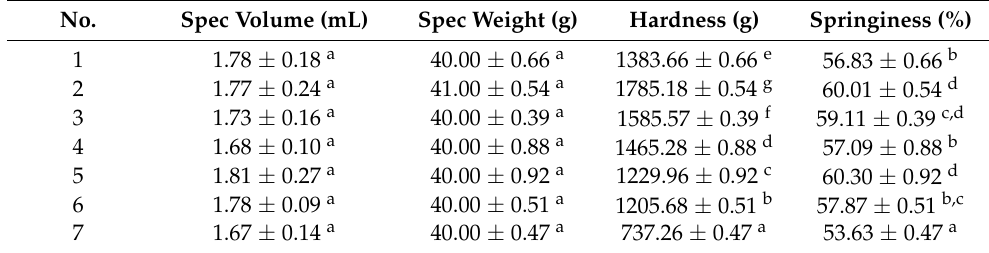
Table 4. Technological characteristics of muffins with Lyo apple and OT+Lyo apple